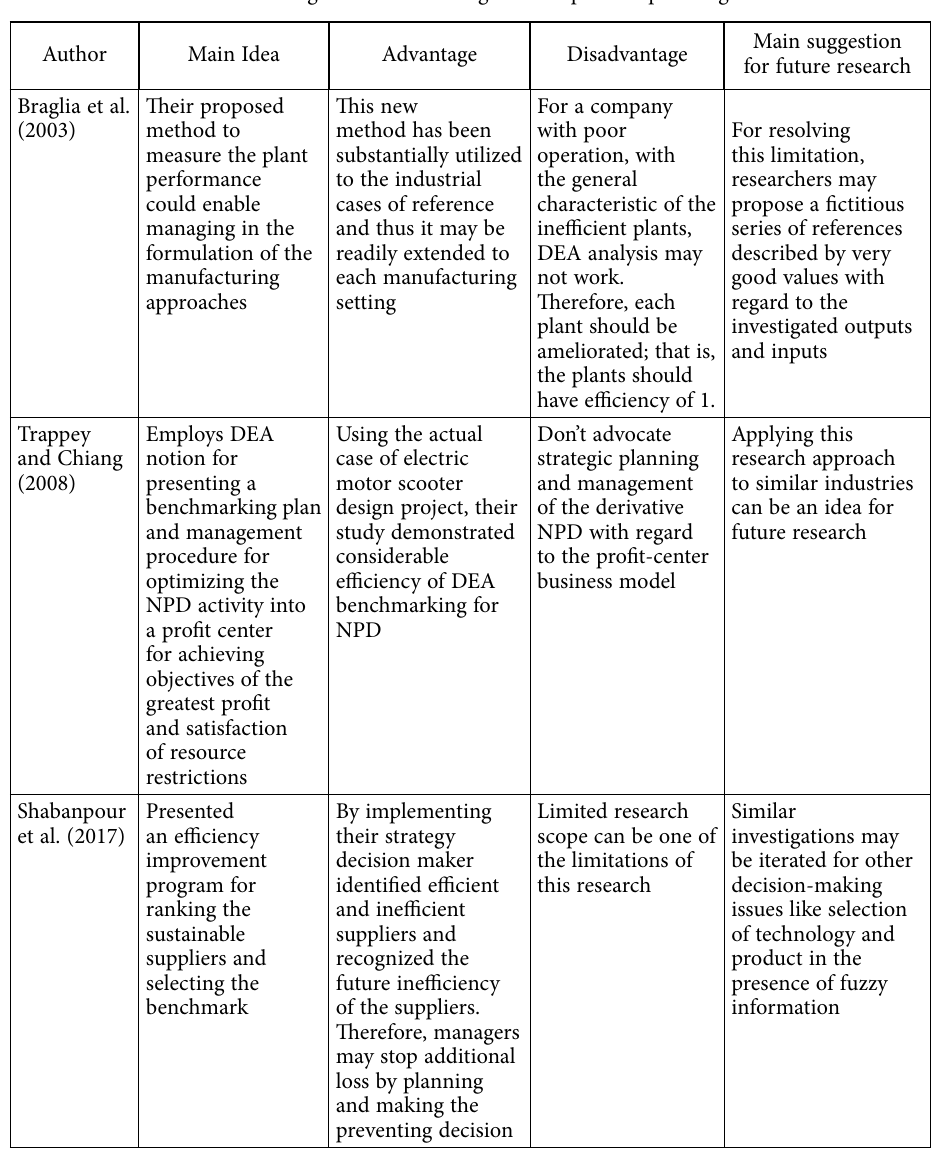
Table 3. Summarizes the advantages and disadvantages of the product planning